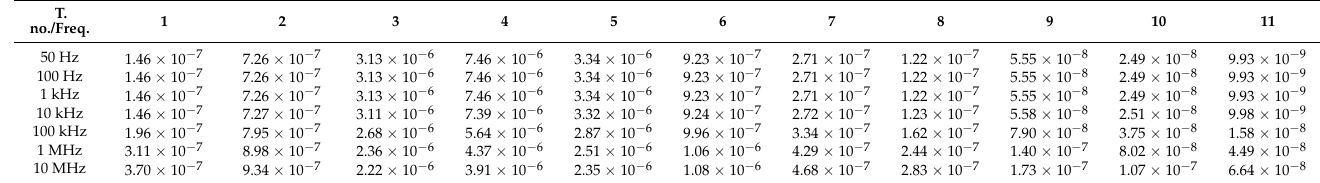
Table A3. Self and mutual inductances of turn 11 (in H) resulting from FEM simulations. T. no./Freq.